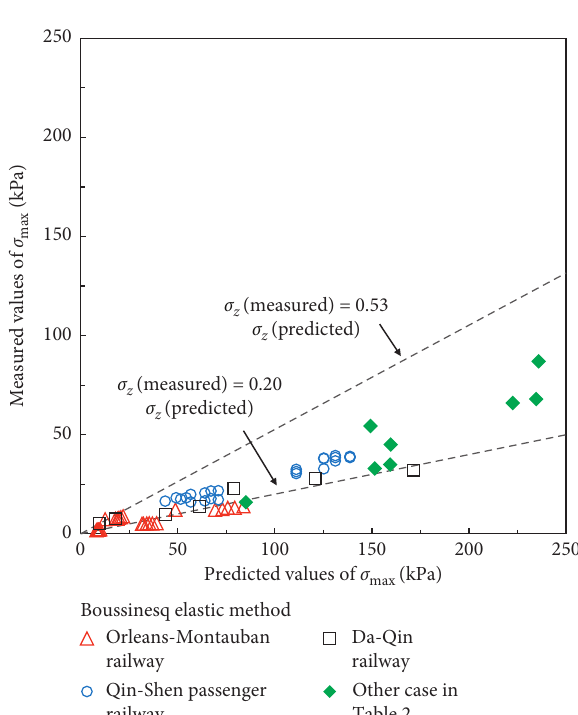
Figure 5: Comparisons between predicted results in the Boussi- nesq method and measured vertical